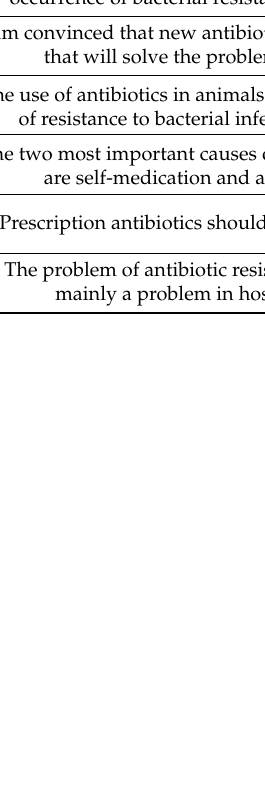
Table 3. Significance of antibiotic resistance in everyday